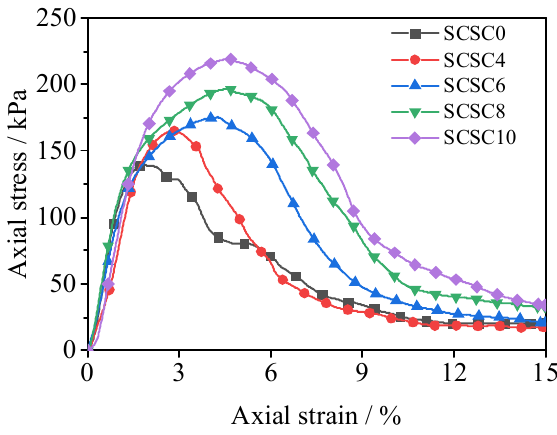
Figure 2. Unconfined compressive strength stress–strain curves of